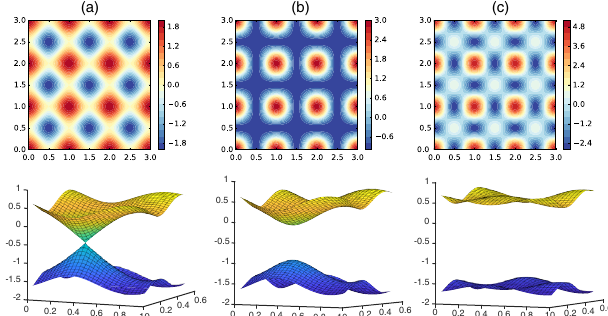
FIG. 3. The lowest Landau level (LLL) under the square lattice potential [Eq. (8)] with the magnetic flux density ϕ ¼ 2 in one unit cell. We take V 1 ¼ V 2 ¼ 1 , (a) V 3 ¼ V 4 ¼ 0 , (b) V 3 ¼ V 0 . 5 , (c) V V 1 . 4 . The upper panel shows the 4 ¼ 3 ¼ 4 ¼ potential pattern, and the lower panel shows the band structure. The LLL splits into two subbands; the lowest band has Chern number C ¼ 1 when V 3 ¼ V 4 > 0 . Tuning the potential pattern gives a nearly flat band as shown in